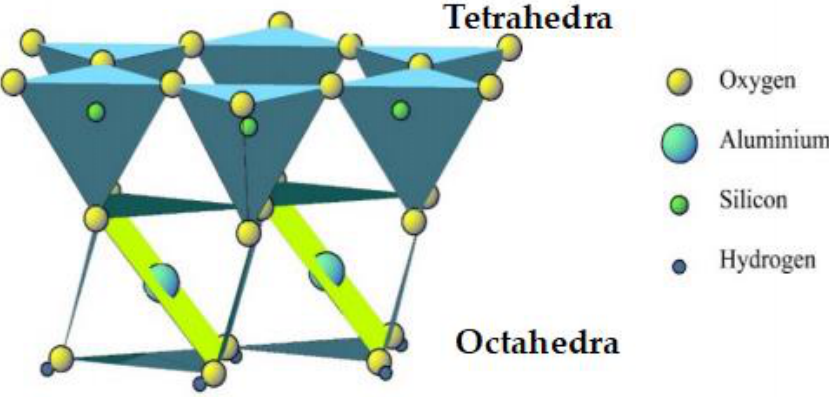
Figure 1. Structure of montmorillonite nanoclay [17].